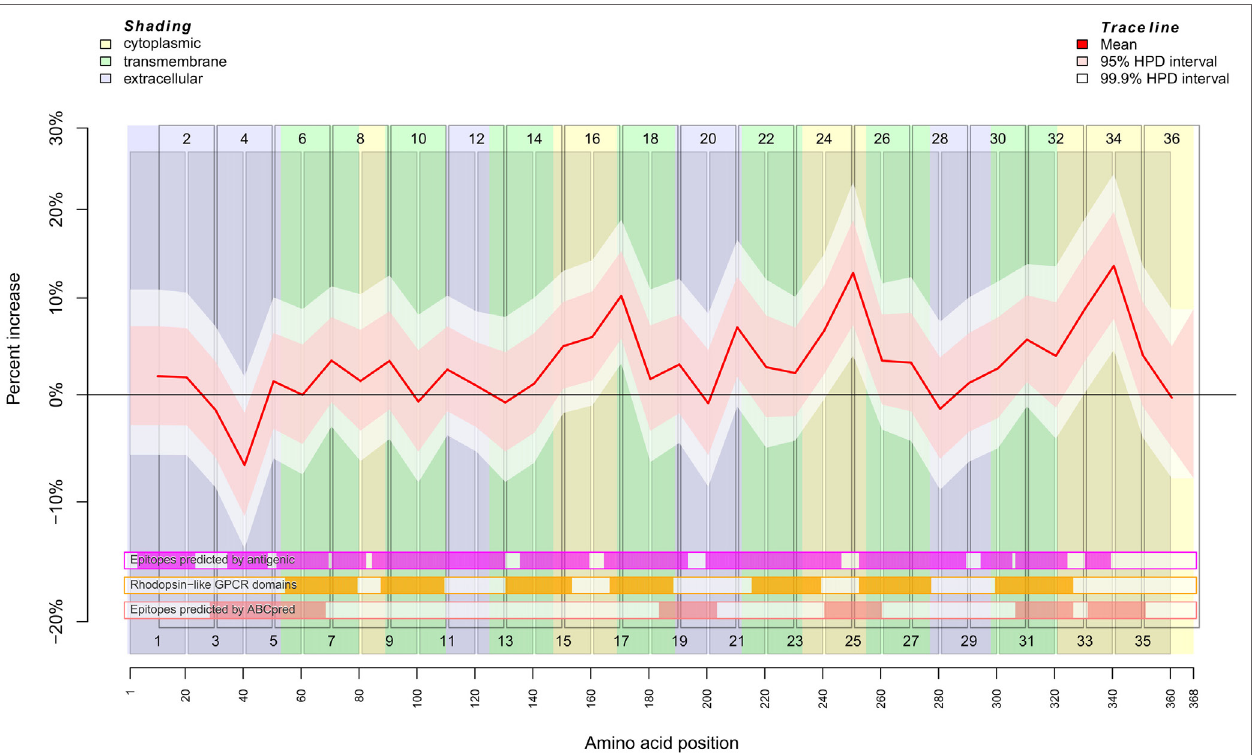
FigUre 1 | Binding behavior of SSc patient and healthy control sera to individual peptides. Plot of the mean expectation value (red line) and 95 and 99.9% credibility bands (pink and white shading) of the SSc patient-specific ab-binding signal (percent increase). The x axis represents amino acid residues 1–368. The peptide localizations are indicated by staggered rectangles that include the peptide numbers. The percent increase indicates the increase or decrease of the binding signal in SSc patients in contrast to an averaged signal. If the 95% (99.9%) credibility interval of the percent increase does not include the zero value (black line), the corresponding peptide is regarded as an epitope that is significantly associated with SSc. By use of the ar1 model, the percent increase, i.e., the binding signal estimator, for a peptide is influenced by the neighboring peptides. Other fixed and random effects of the statistical model are shown in Figures S2 and S3 in Supplementary Material. At the bottom, three heat maps indicate the position of putative epitopes predicted by antigenic (magenta hue), ABCpred (pink hue) and the presence of rhodopsine-like domains (orange hue). The background colors indicate the position of intracellular (yellow hue), transmembranous (green hue), or extracellular (blue hue) amino acid